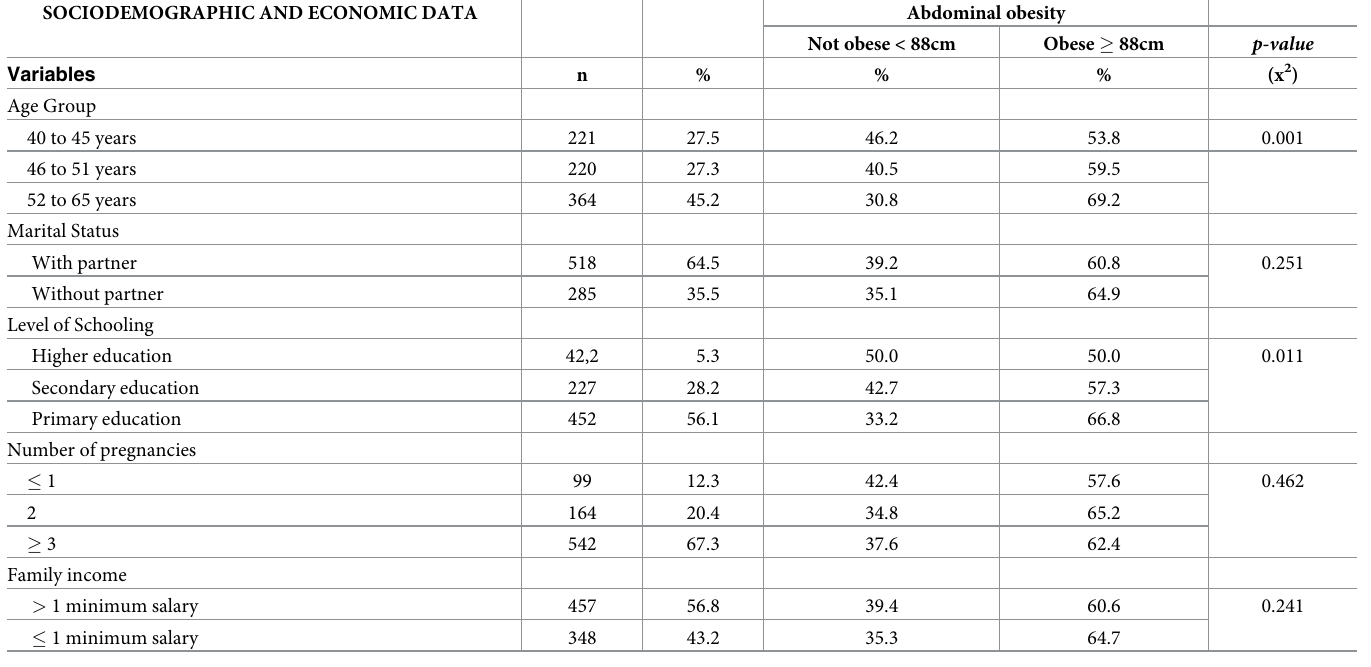
Table 1. Distribution of absolute and relative frequencies and bivariate analysis between abdominal obesity and socio-demographic and economic variables in cli- macteric